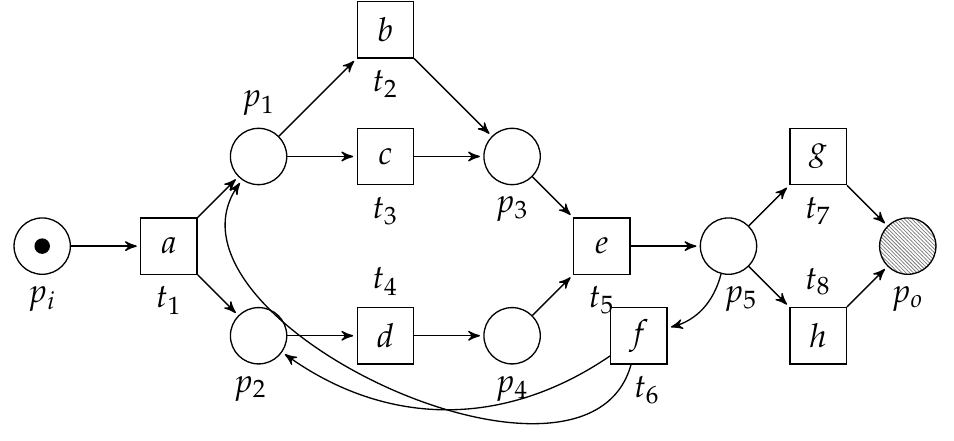
Figure 3. WF-net W 1 [1] with initial marking [ p i ] and final marking [ p o ]